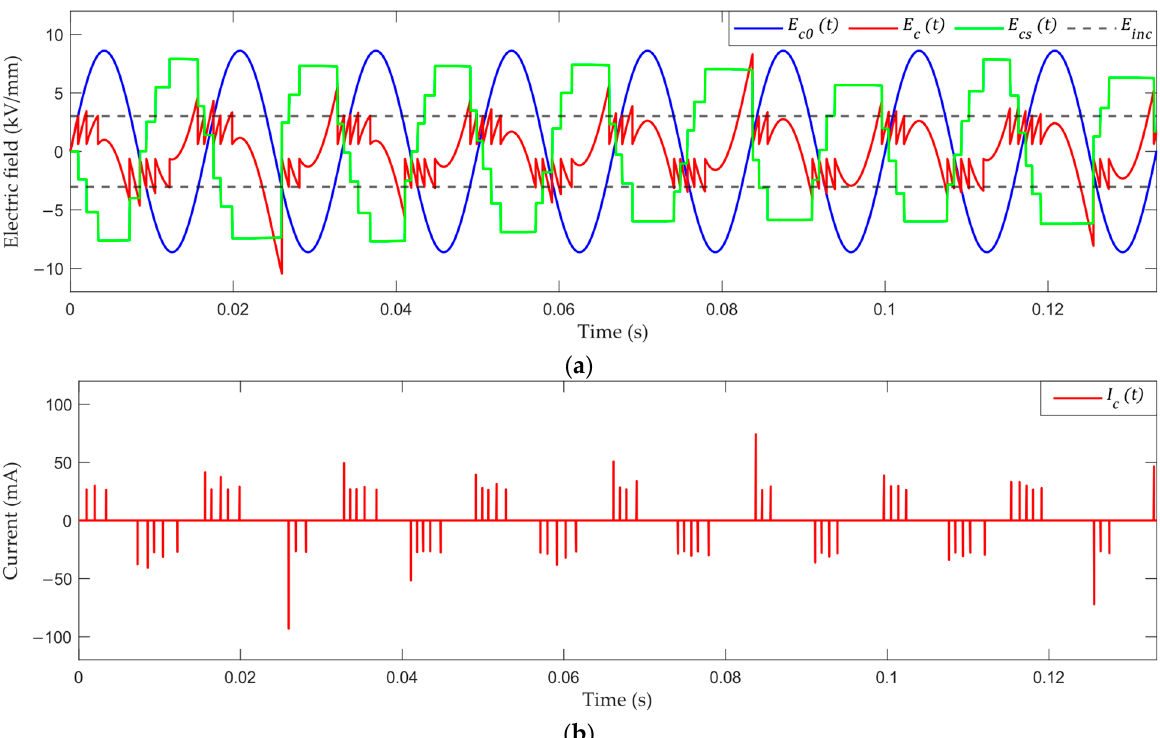
Figure 4. Simulated results for the case wherein a purely sinusoidal voltage was applied: ( a ) electric fields over time; ( b ) PDs current pulses.